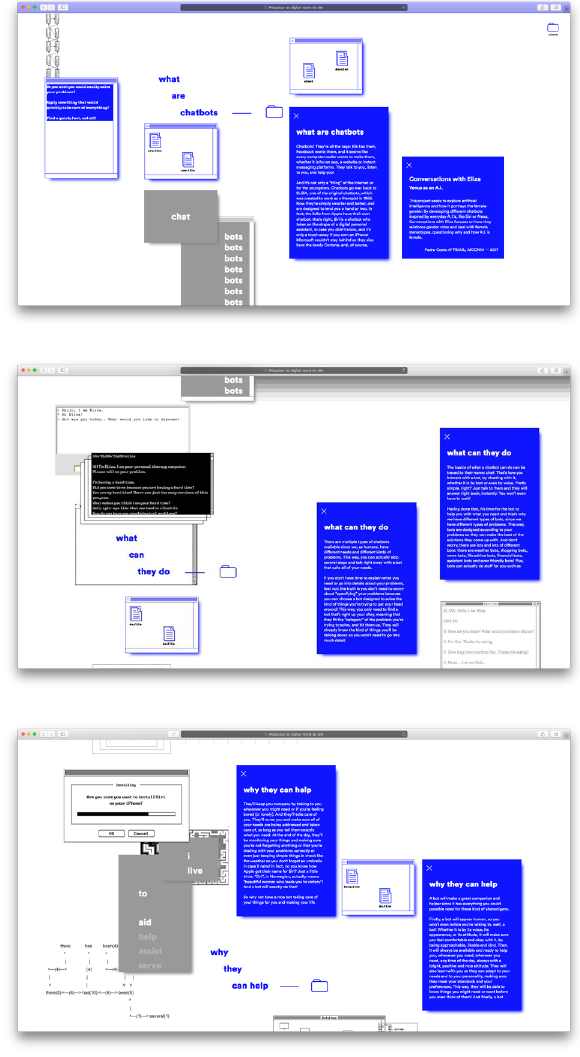
Figure 2 | Section that provides context on